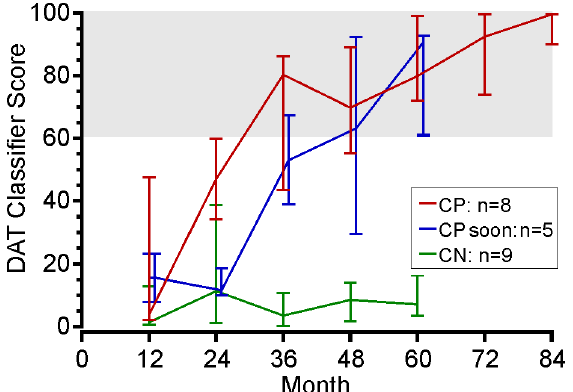
Figure 4. A plot of the mean DAT classifier scores (highest and lowest) for subjects who met the clinical criteria for DAT (CP, red line), would soon meet the criteria (CP-soon, blue line) or did not yet meet the criteria (CN, green line). Note that this assessment was applied at the PwP’s most recent visit and that not all subjects have been followed for the same length of time.